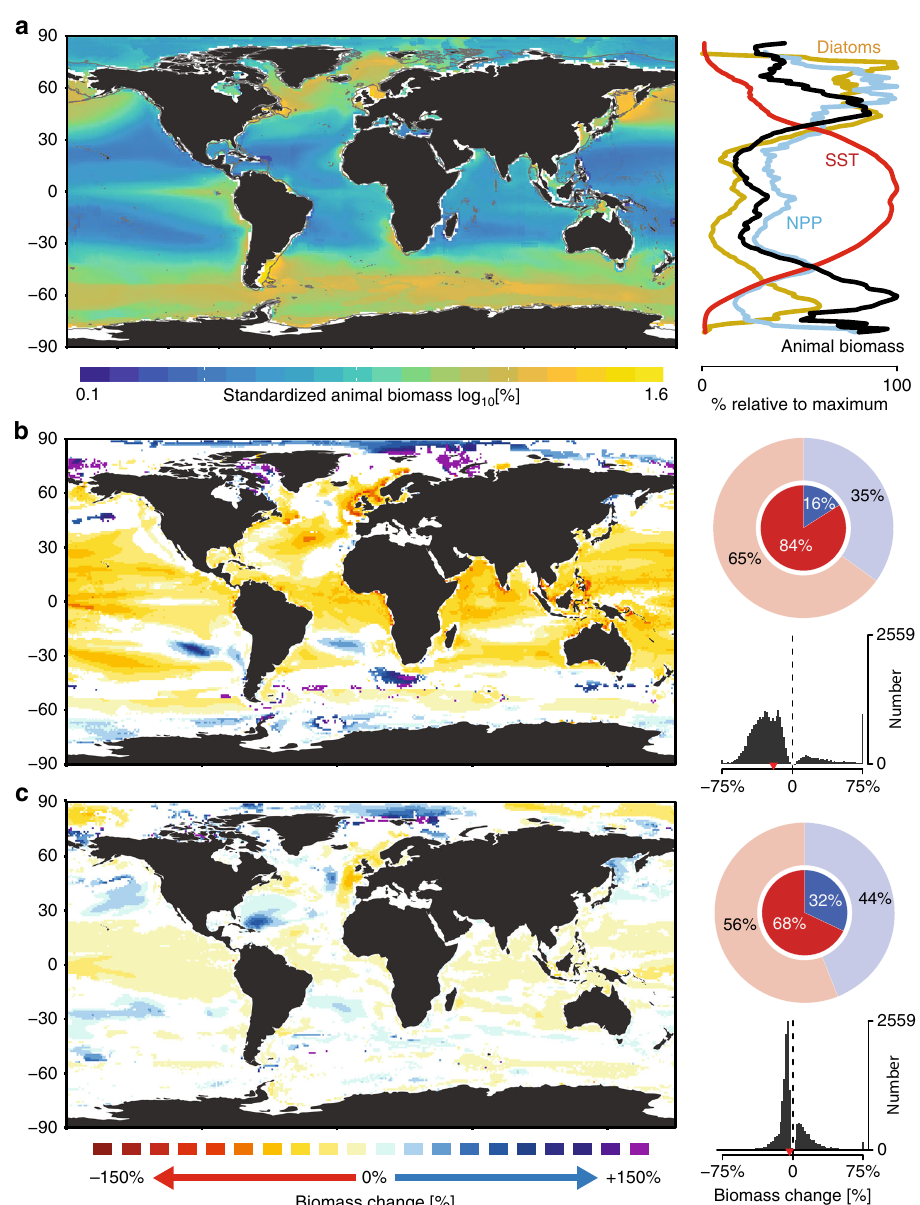
Fig. 2 Global patterns of marine animal biomass and projected change. a Average standardized biomass of marine animals from multi-model projections for the contemporary period (2006 – 2016). Left: Map depicts animal biomass density in each grid cell, relative to the global maximum and normalized. Gray lines depict the 200 m isobath. Right: graph shows the latitudinal variation in present-day animal biomass (black), SST (red), NPP (blue), and diatom frequency (yellow). b , c Maps of projected future change in animal biomass between 2006 and 2100, relative to the reference period (2006 – 2016) under a worst-case scenario RCP8.5 ( b ) and strong mitigation scenario RCP2.6 ( c ). White depicts grid cells containing non-signi fi cant trends ( p > 0.05) or containing insuf fi cient data for analysis. Circular histograms depict the proportion of grid cells where analyses were possible that contained increasing (blue) or declining (red) changes. Inner opaque shading depicts changes that were statistically signi fi cant ( p < 0.05), and outer shading depicts those that were both statistically signi fi cant and non-signi fi cant. Histograms show the distribution of all statistically signi fi cant predicted changes per grid cell with global means denoted as red arrows. Projected changes in b , c were estimated using longitudinal models. Data sources are listed in Table